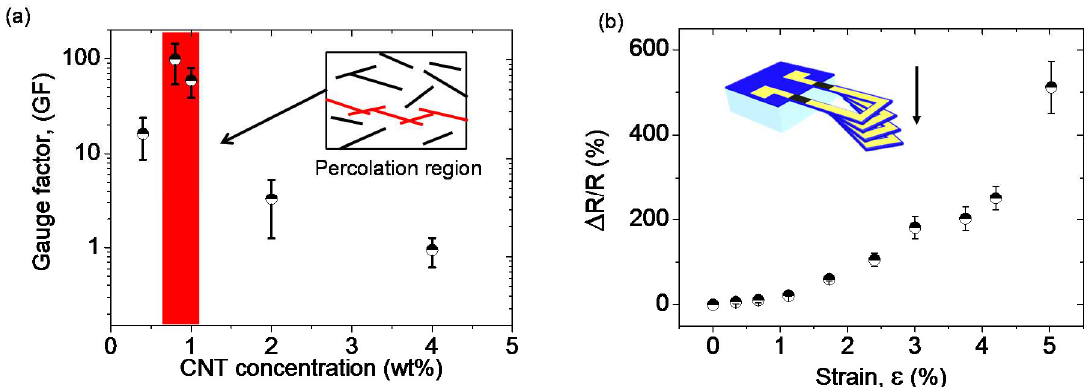
Figure 1. ( a ) Gauge factors of CNT/SU-8 composites as a function of CNT concentrations at 3.0% of applied strain, highlighting the highest sensitivities obtained at the percolation region; ( b ) Relative change of resistance of piezoresistive MEMS as a function of applied strain for a CNT concentration of 2 wt %.